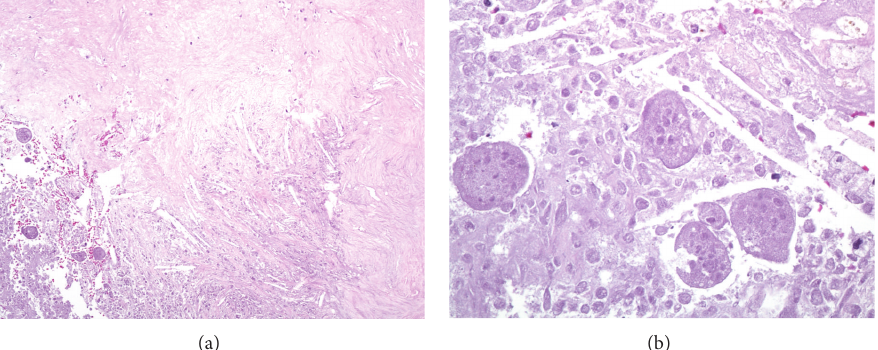
Figure 3: Representative photomicrographs of the paraspinal mass after denosumab therapy. At low magnification ((a); 100x, hematoxylin and eosin), extensive necrosis is apparent with abundant cholesterol clefts (center) and surrounding fibrosis (top). Residual tumor is focally recognizable but is entirely necrotic (lower left), and no viable tumor is present. At high power ((b); 400x, hematoxylin and eosin), “ghosts” of necrotic multinucleated osteoclastic giant cells are present among necrotic mononuclear tumor